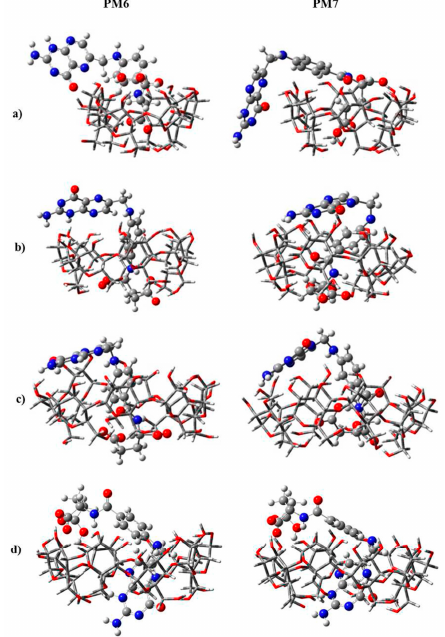
Figure 10. Structures of the most energetically favorable doubly negatively charged noncovalent complexes of FA with ( a ) α -CD, ( b ) β -CD, and ( c and d ) γ -CD obtained from PM6 and PM7 complexes of FA with ( a ) α -CD, ( b ) β -CD, and ( c , d ) γ -CD obtained from PM6 and PM7 semiempirical calculations. Reprinted with permission from Reference [179]. Copyright (2014), semiempiricalcalculations.ReprintedwithpermissionfromReference[179].Copyright(2014), American American Chemical Society. Chemical